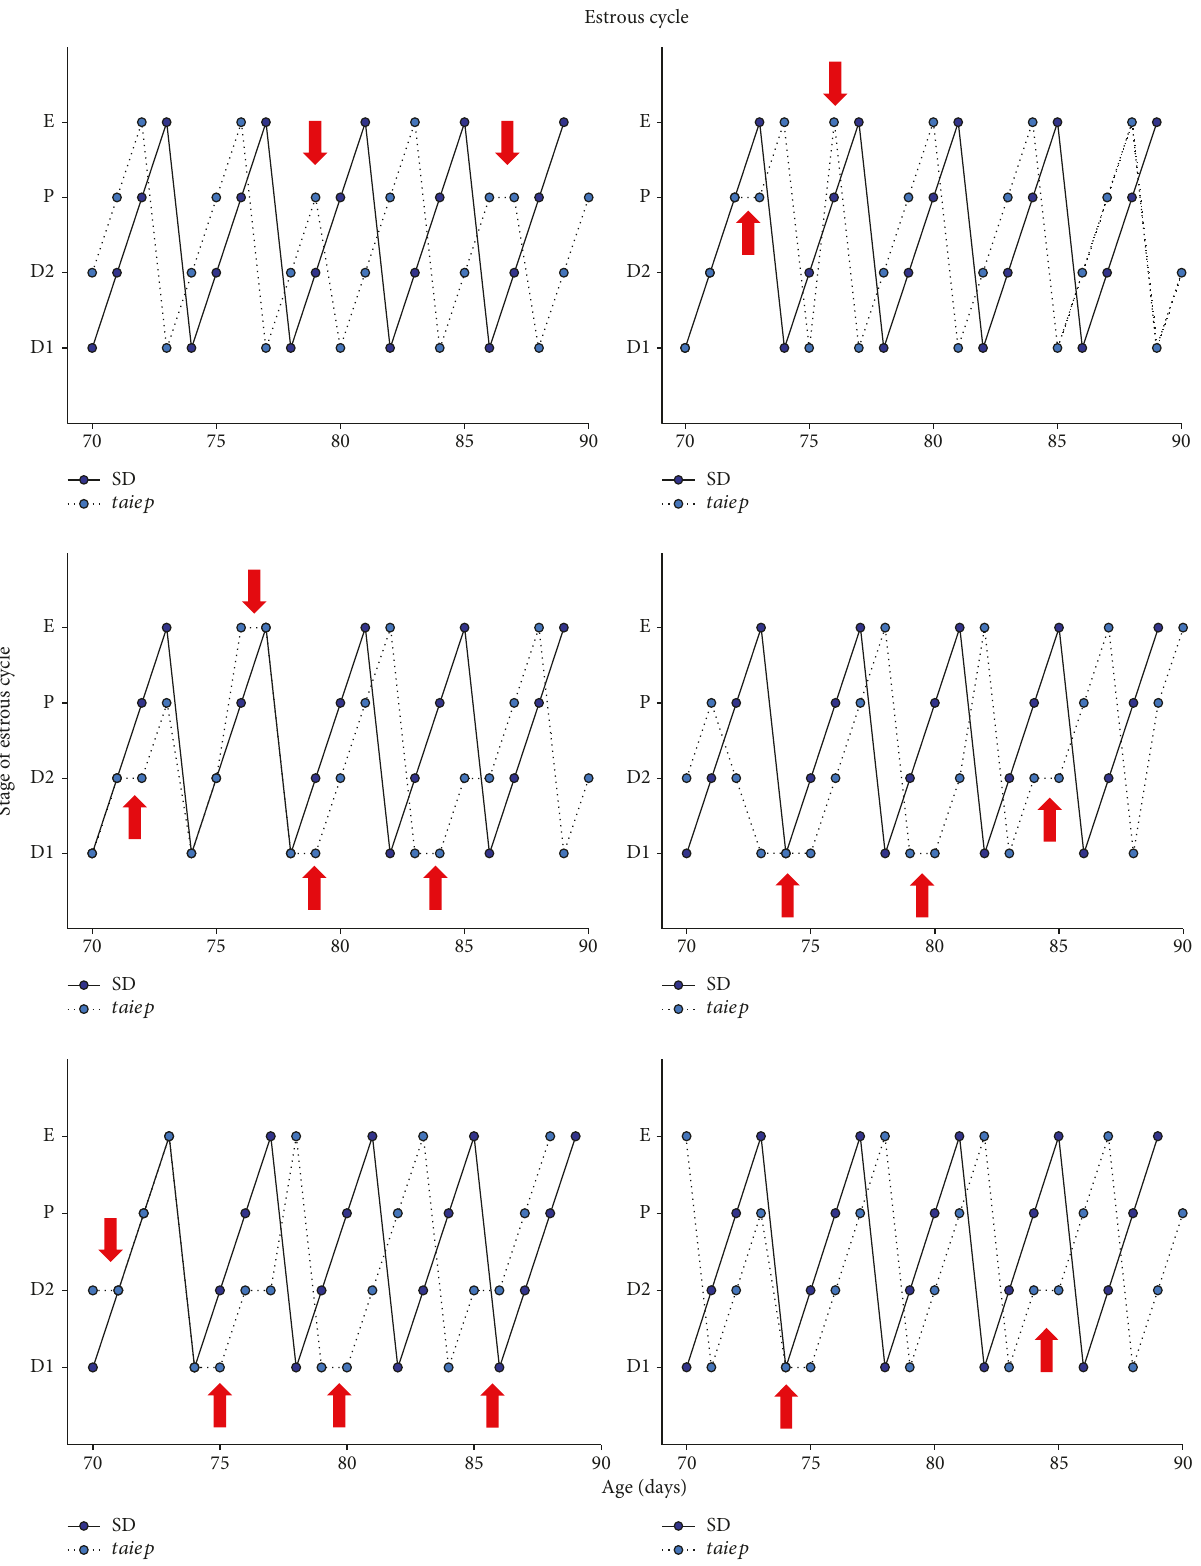
Figure 6: Estrous cycle of Sprague – Dawley and taiep rats from 70 days of age until sacri fi ce. Each graph represents the estrous cycle of one Sprague – Dawley and one taiep rat. The estrous cycle comprises four stages: estrus, diestrus 1, diestrus 2, and proestus. Red arrows indicate the moments when the estrous cycle of the taiep rat is irregular. SD: Sprague – Dawley; E: estrus; D1: diestrus 1; D2: diestrus 2; P: